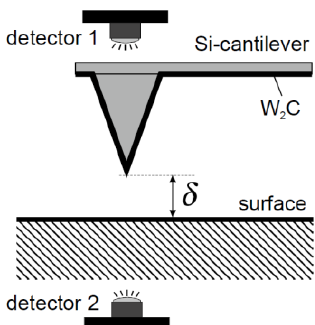
Fig. 1. The schematic illustration of the probe-surface system with the tunnel-transparent gap  . To create electric charge at local 10×10 um 2 areas of the surface, during the scanning needle point HA-HR/W C and conducting semiconductor (n-n + -Si{111}) or non- 2 conducting dielectric (thermal oxide SiO /n-n + -Si{111}) surfaces. There were two cases 2